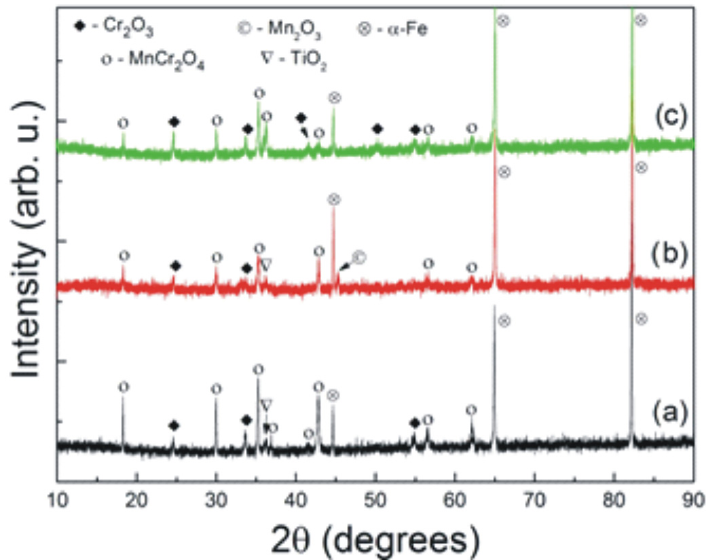
Figure 8. Diffraction patterns recorded for: ( a ) unmodified Crofer 22APU steel, ( b ) Crofer 22APU with the deposited SiC x N y :H layer, and ( c ) Crofer 22APU with the layer deposited after N + ion modification (N + /SiC x N y :H) obtained after oxidation at 1073 K in the air for 500